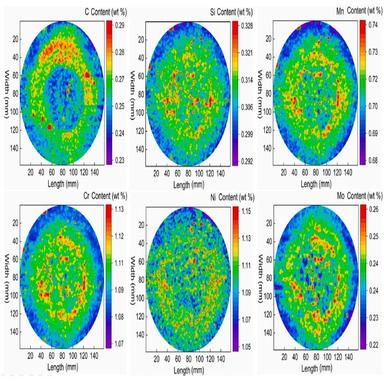
Coupled 2-D content distribution of C, Si, Mn, Cr, Ni, Mo in A11 sample.